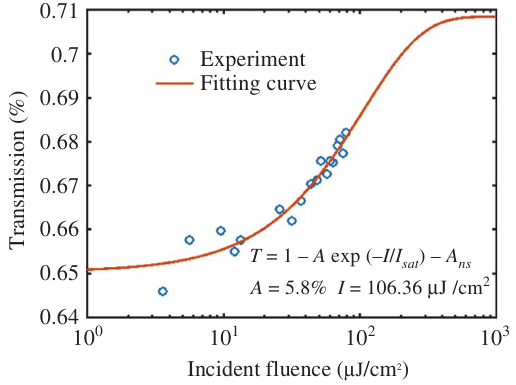
Figure 6: Nonlinear transmittance as a function of incident fluence.